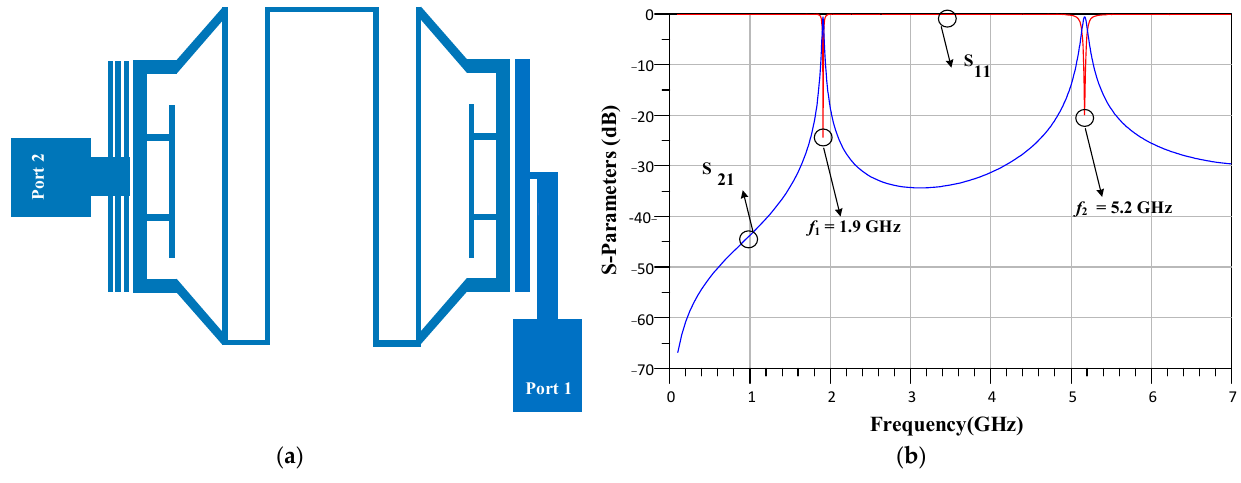
Figure 2. The ( a ) structure and ( b ) response of resonator2. In order to create a compact BPF with high attenuated stop band, resonator1 and resonator2 are combined to form the final structure of the first BPF. Figure 3 shows the structure of the first designed band-pass filter, which passes signals at 1.9 GHz and 3.6 GHz frequencies and suppresses other frequencies. The simulated frequency responses of this proposed filter are depicted in Figure 4. The insertion losses (IL) at the operating fre- quencies are 0.52 dB and 0.76 dB, and the return losses (RL) parameter values are better than 40 dB and 33 dB, respectively.